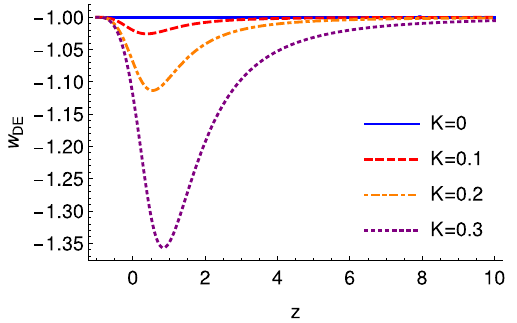
Fig. 4 The evolution of the effective dark energy equation-of-state parameter w DE , for different values of the Kaniadakis entropic param- eter K . We have imposed (cid:4) m 0 ≈ 0 . 3 at present time in units of k B , and in all cases we have obtained density parameters evolution similar to the graphs of Fig.